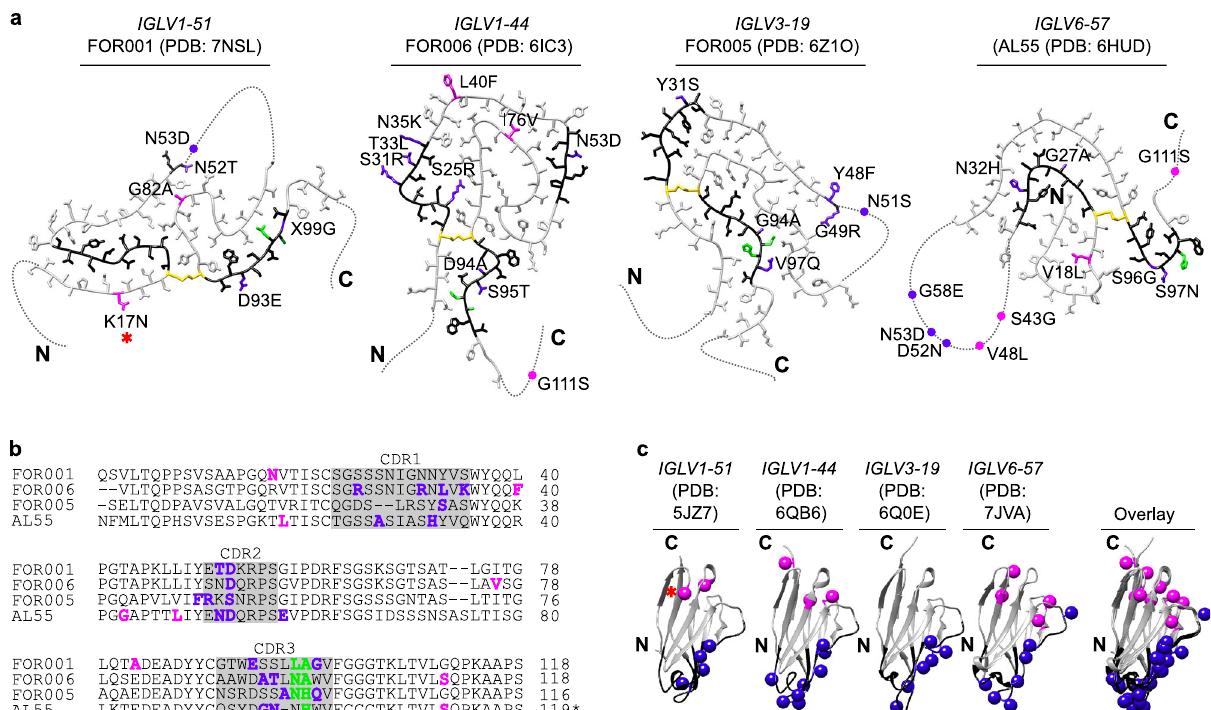
Fig. 4 Location of the mutations in known AL amyloid fi brils and natively folded V L domains. a Location of the mutations in known AL amyloid fi bril structures. The fi brils are derived from the GL segments IGLV1-51*02 λ 1 (FOR001, this study, PDB 7NSL) IGLV1-44*01 λ 1 (FOR006, PDB 6IC3 10.2210/ pdb6IC3/pdb) 21 , IGLV3-19*01 λ 3 (FOR005, PDB 6Z1O 10.2210/pdb6Z1O/pdb) 23 , and IGLV6-57*02 λ 6 (AL55, PDB 6HUD 10.2210/pdb6HUD/pdb) 22 . Disordered parts of the fi bril proteins are indicated by dotted lines. Black: CDRs; yellow: Cys. Indigo: mutations in the CDRs and one residue before or after a CDR; magenta: mutations in framework regions; green: residues in the junctional region at the V/J interface. Red star: location of the glycosylation. b Sequence alignment of the four fi bril proteins. CDRs are marked with gray boxes. Color coding as in ( a ). c Location of mutations in the corresponding, natively folded LC V L domains that are based on the GL segments IGLV1-51*01 (PDB 5JZ7 10.2210/pdb5JZ7/pdb), IGLV1-44*01 (PDB 6QB6 10.2210/ pdb6QB6/pdb) IGLV3-19*01 (PDB 6Q0E 10.2210/pdb6Q0E/pdb) and IGLV6-57*02 (PDB 7JVA 10.2210/pdb7JVA/pdb) CDRs are marked in black. Color coding as in ( a